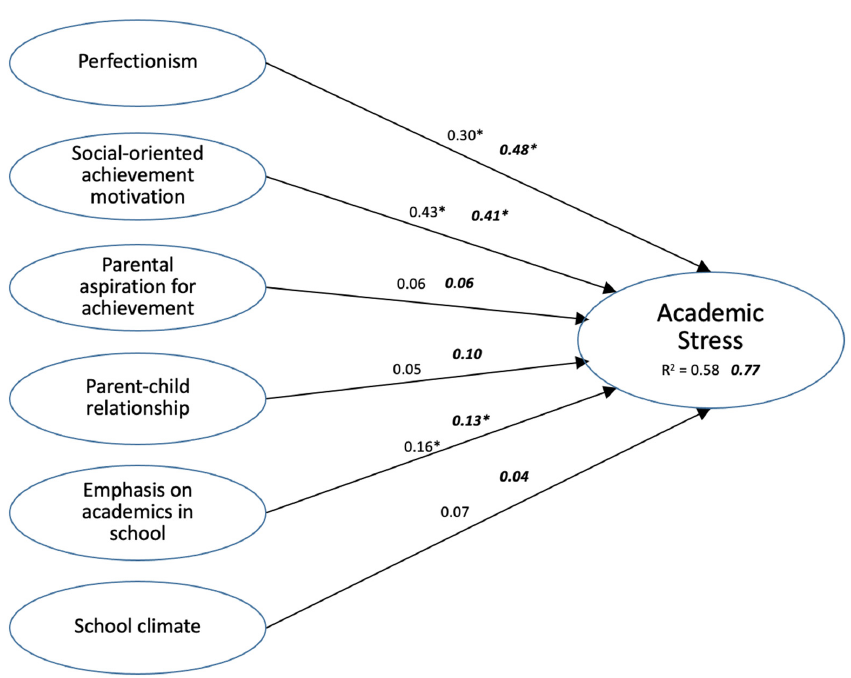
Figure 2. Structural equation modelling of effects on males’ (regular print) and females’ (bold italics) academic stress by perfectionism, social-oriented achievement motivation, parental aspiration for achievement, parent–child relationship, emphasis on academics in school, and school climate (numbers are the standardized effects. Those with * are significant at p <